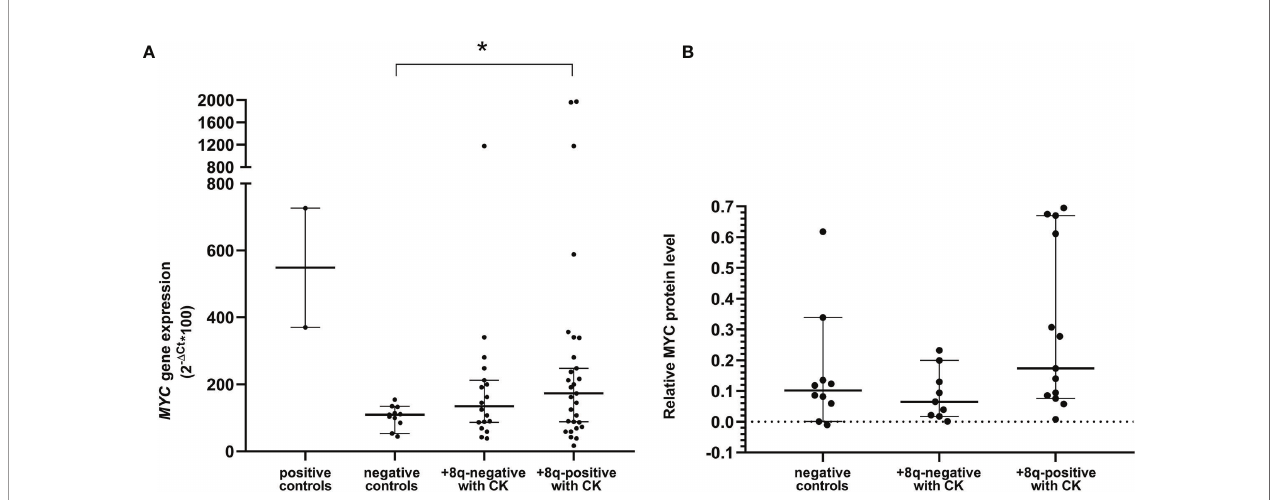
FIGURE 4 | (A) Quanti fi cation of MYC mRNA levels using quantitative real-time PCR (qRT-PCR). (B) Quanti fi cation of MYC protein levels using western blot immunodetection. Positive controls: cell lines NALM6 and MEC-1. Negative controls: patients negative in both the cytogenetic and molecular-cytogenetic analyses (n=10). +8q-positive with CK; patients with complex karyotype and MYC aberration (n=13). +8q-negative; patients with complex karyotype but without MYC aberration (n=9). The Mann-Whitney tests were applied to con fi rm a signi fi cant difference in gene expression between the groups. A statistically signi fi cant difference (p=0.05) is marked by an asterisk.